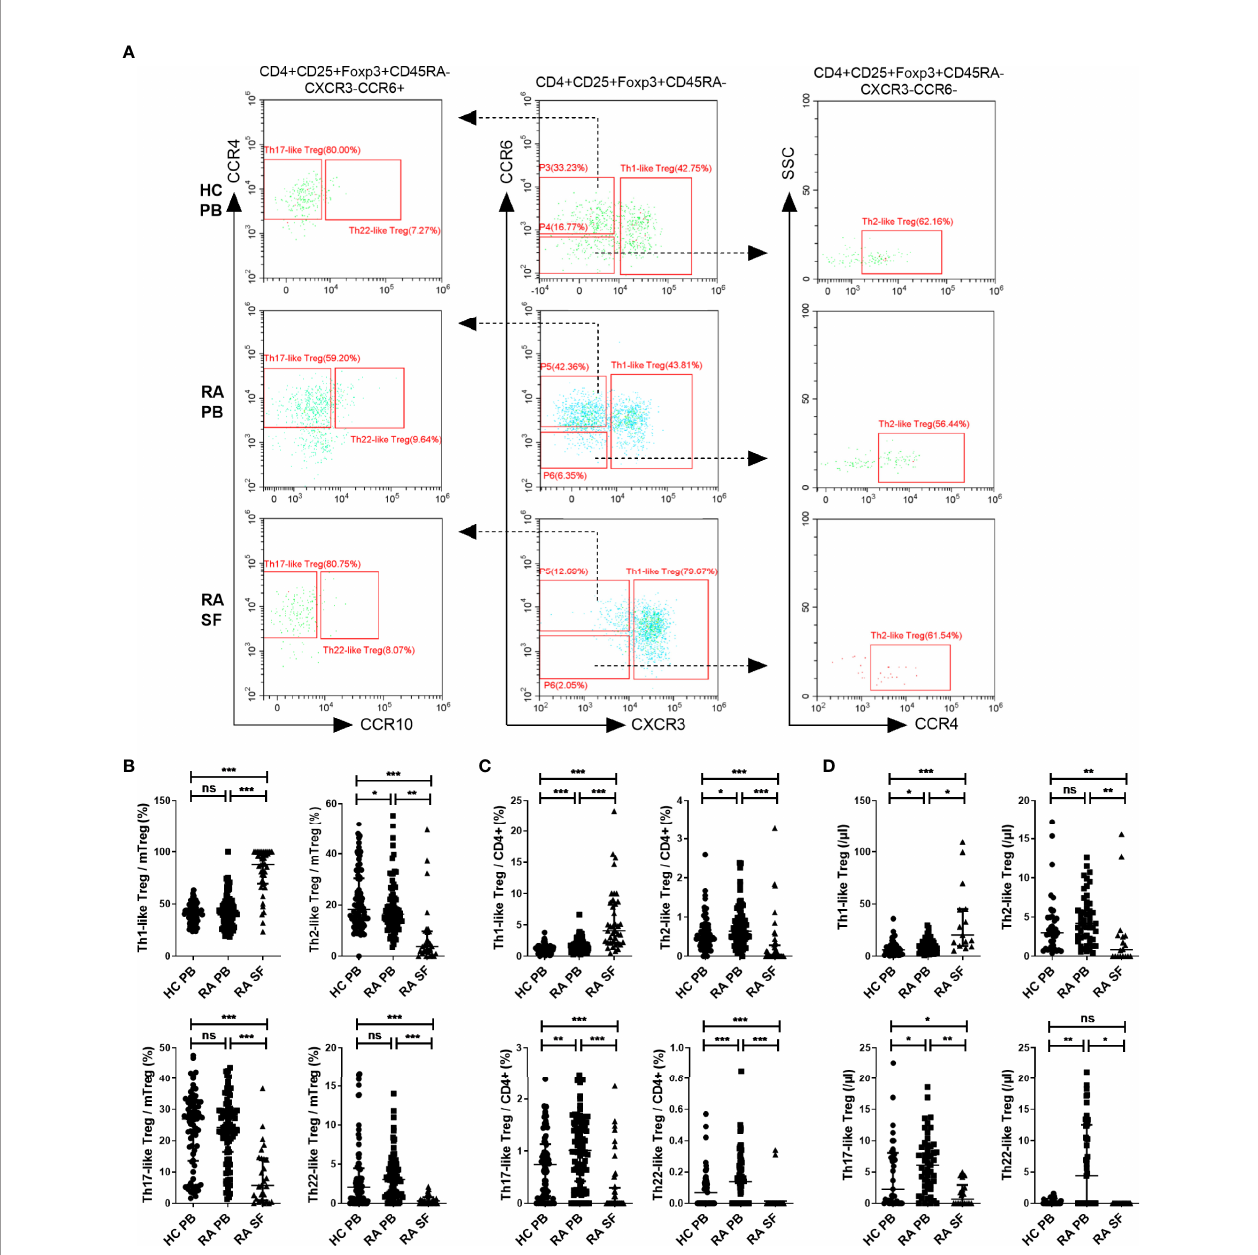
FIGURE 2 | The comparation of different Th-like Treg subsets among HC PB, RA PB, and RA SF. (A) Flow cytometric dot-plots and gating strategies of different Th-like Treg cells in HC PB, RA PB, and RA SF. (B – D) Cumulative data of different Th-like Treg cells in HC PB, RA PB, and RA SF. Data are from 86 RA patients, 76 healthy donors and 42 SF samples. * p < 0.05, ** p < 0.01, *** p < 0.001, ns, not statistically signi fi